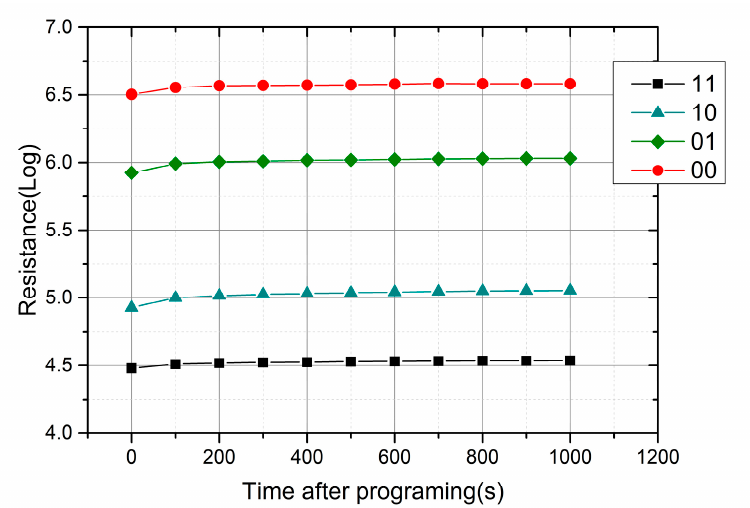
Figure 12. Measurements showing the multilevel drift behavior for a 1000 s time frame.